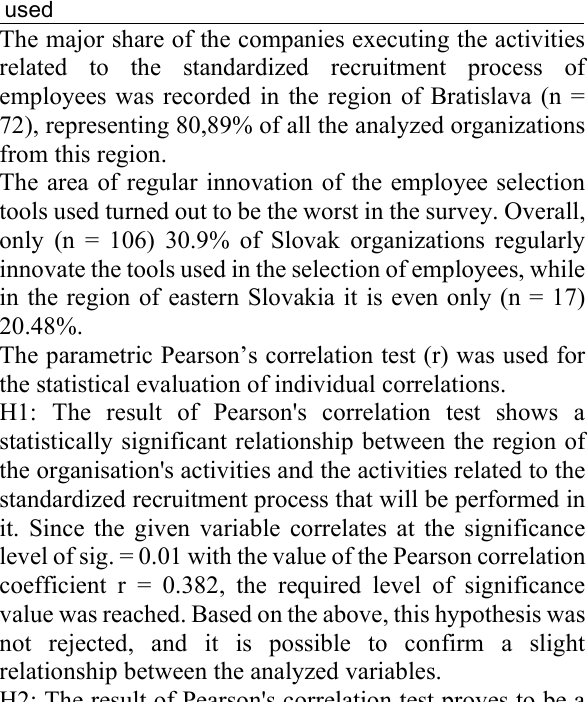
the selection tools